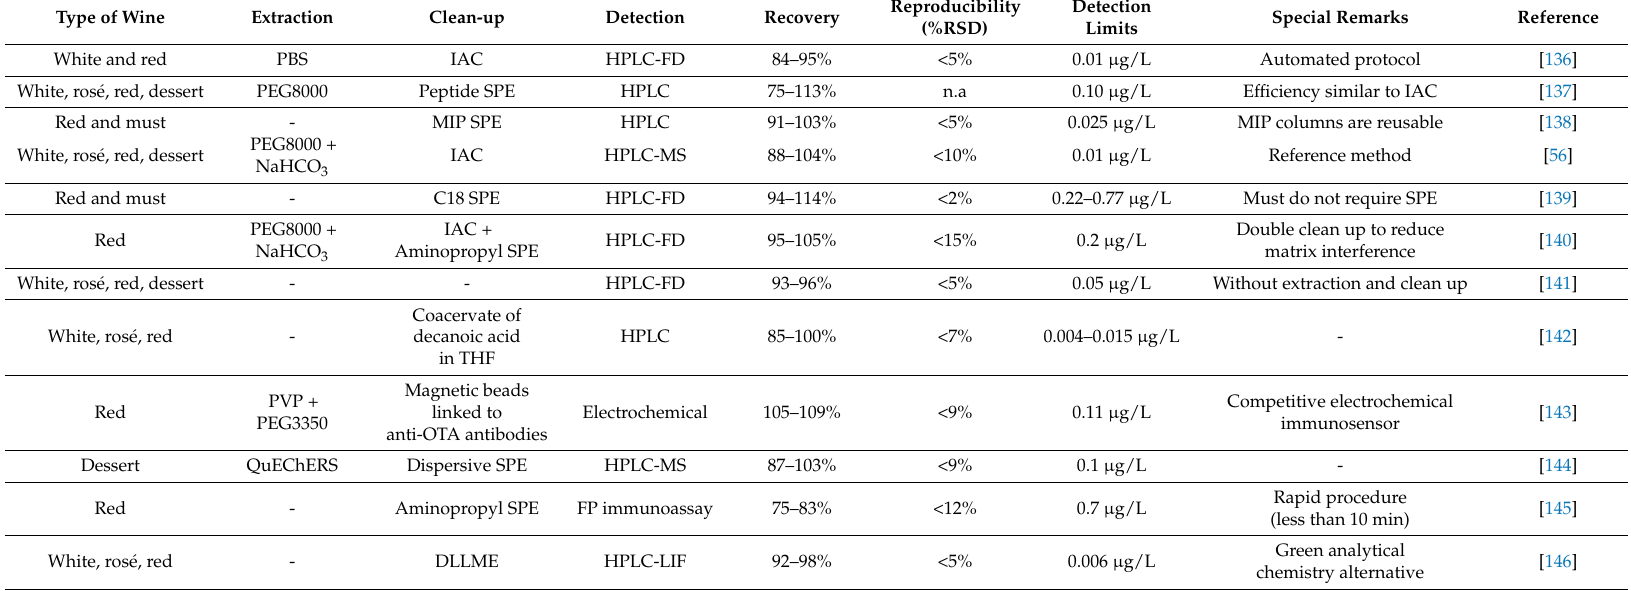
Table 2. Methods for determination of OTA in